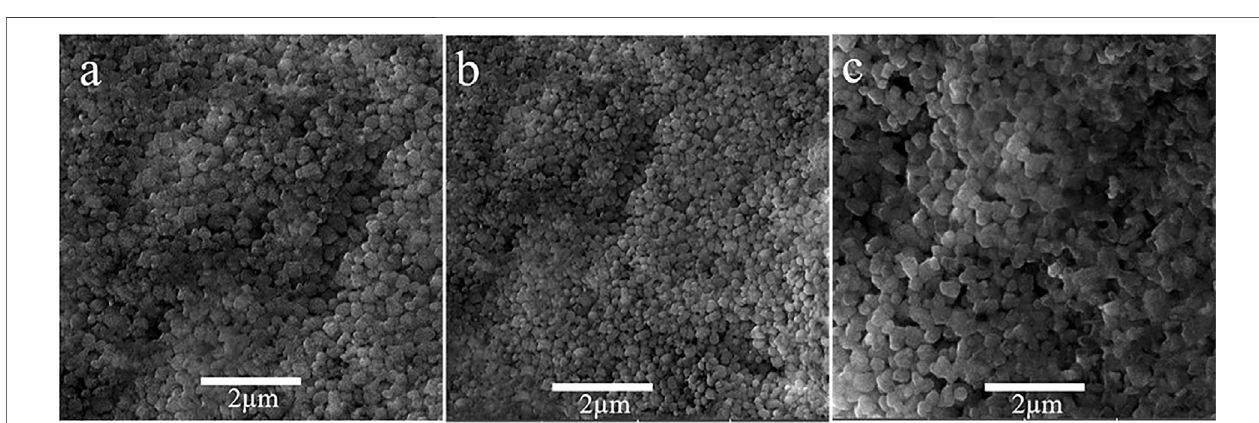
FIGURE 7 | SEM top view of perovskite layer deposited on (A) ZnO ETL, (B) 1% Al, and (C) 2% Al.